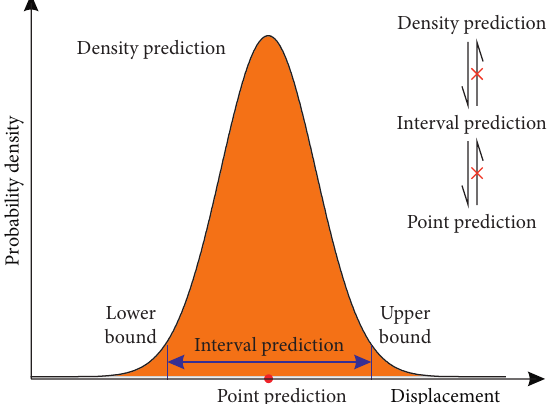
Figure 1: Schematic diagram of point prediction, interval pre- diction, and density